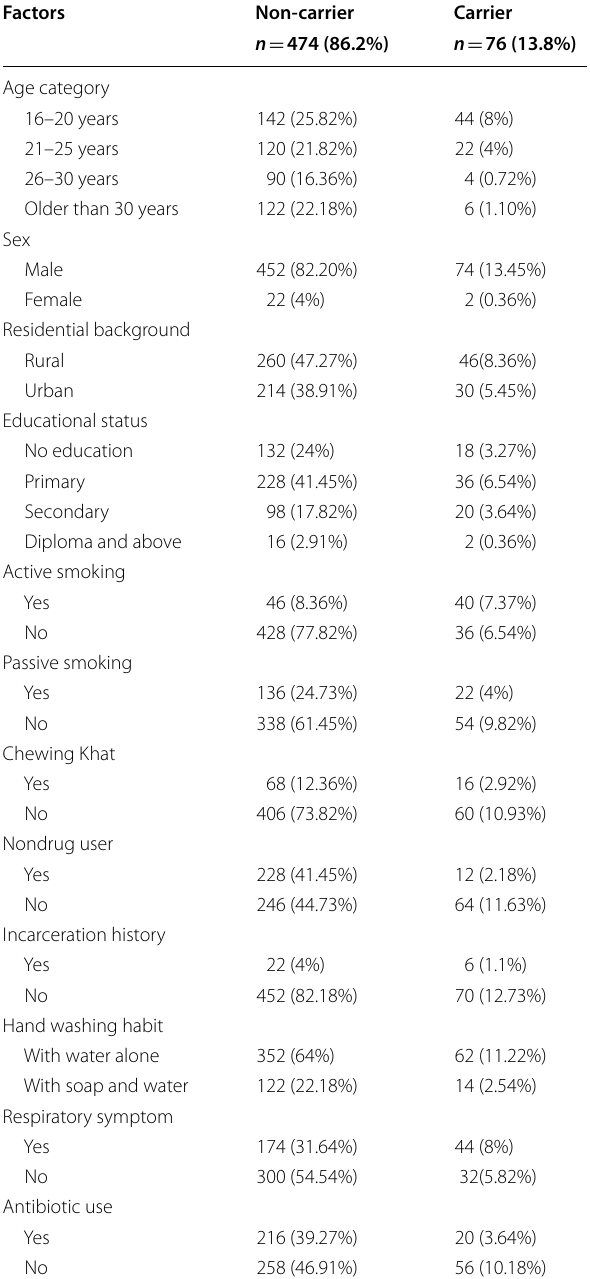
Table 1 Sociodemographic, behavioral and health-related characteristics of prisoners at correction facility in Jimma Town, Southwestern Ethiopia in 2019